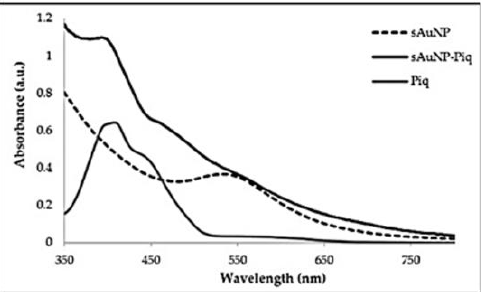
Figure 4. UV/Visible absorption spectra of the sAuNP, a representative pyrroloiminoquinone me- tabolite (BDC ( 5 )), and their conjugate with the sAuNP in water.